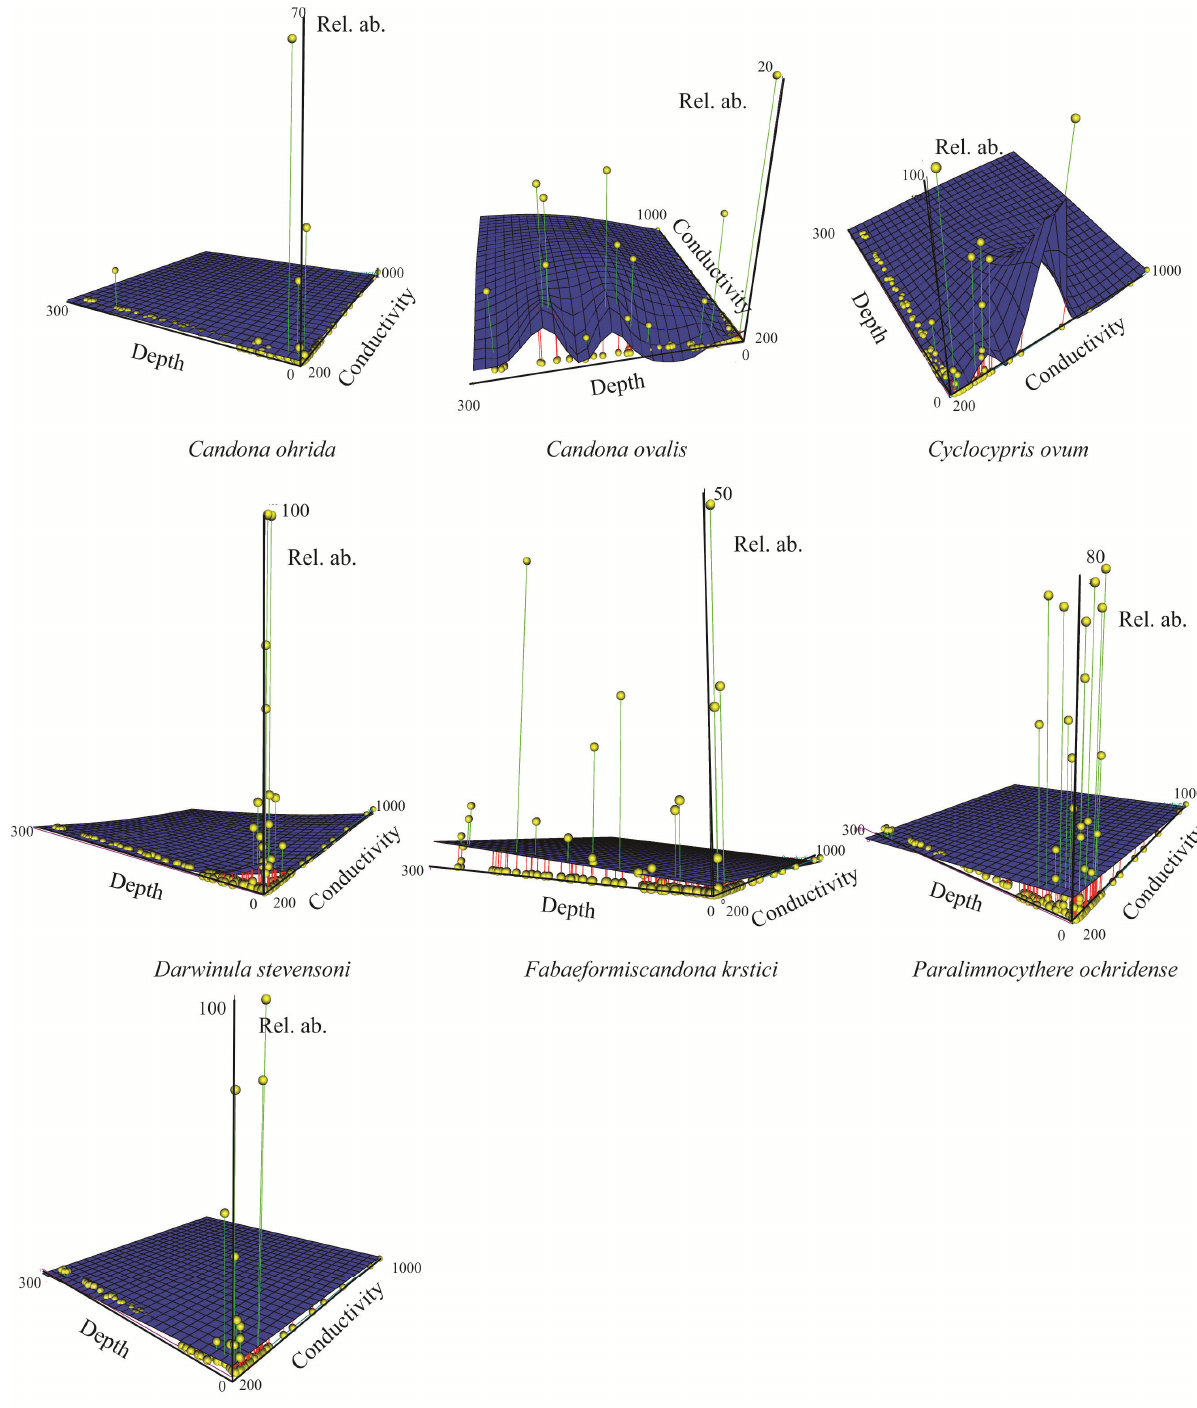
Figure 8. 3D scatter plot of species relative abundance (%) as a function of depth (m) and water conductivity ( μ S cm − 1 ) reported for species collection sites. Vertical lines and spheres indicate the species relative abundances. Blue surface shows modeled abundance through smooth regression. Only species present in ≥ 10 sites are